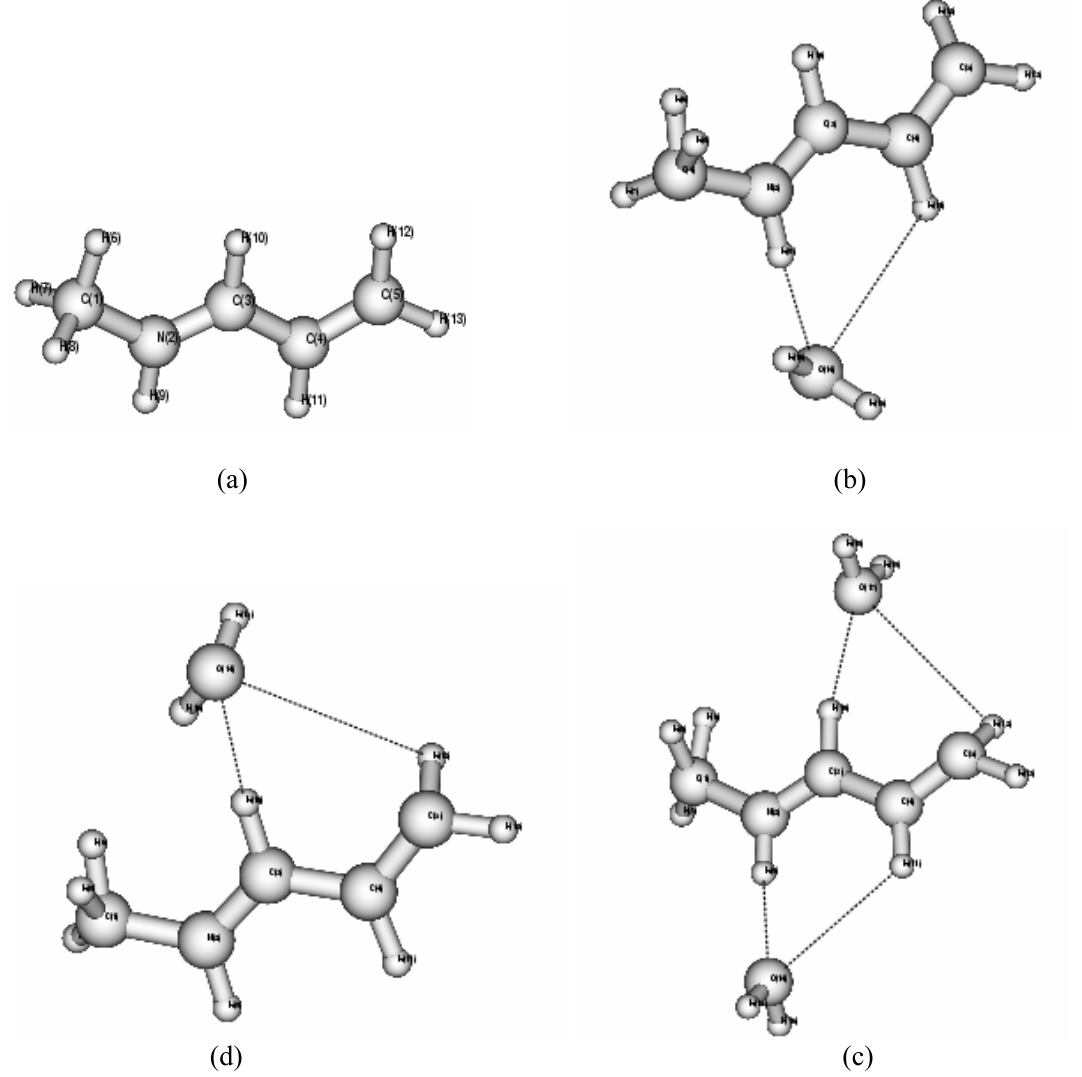
Figure 1. Molecular structures of (a) NMP (b) NMP-water along NH side (c) NMP-water at CH side (d) NMP-water along both the